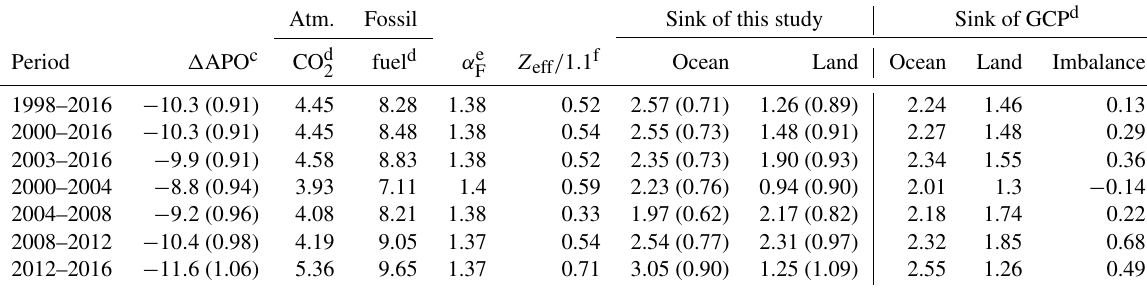
Table 2. Comparison of global carbon budgets based on APO with those from GCP a , b .